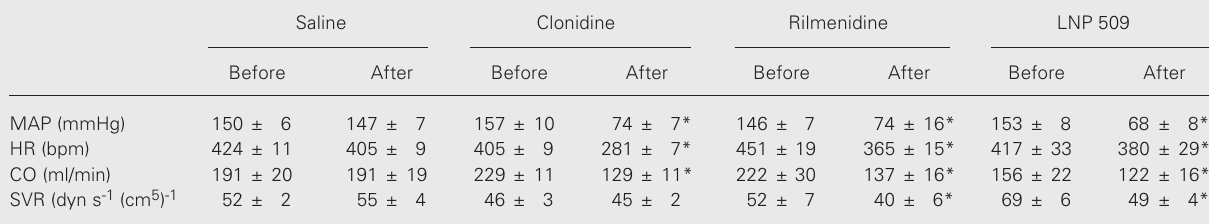
CO = cardiac output; HR = heart rate; MAP = mean arterial pressure; SVR = systemic vascular resistance. Each value represents the mean ± SEM for 6